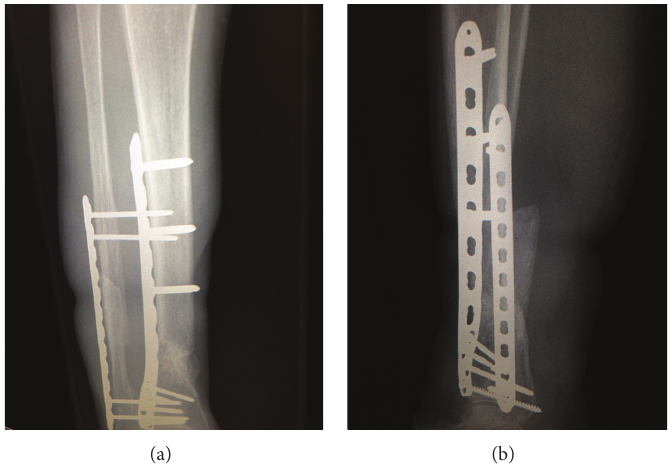
Figure 4: AP (a) and lateral (b) radiographs taken 6 months later showing osseous consolidation.